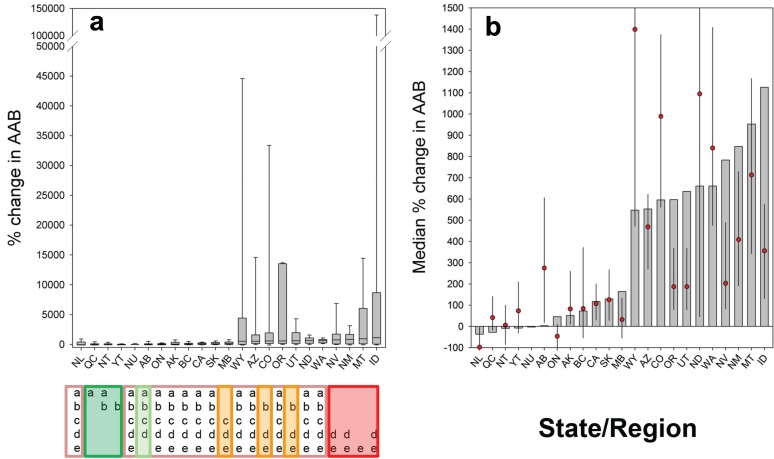
Changes in AAB across United States and Canada by state/province.(a) Boxplot of percent change in AAB (2010–2039 vs.1961-2004, SRES A1B scenario) binned by US state or Canadian province, based on significant models with p < 0.05. Sharing of any letter (below the graph) indicates lack of significant differences in medians of percent change in AAB based on Bonferroni-corrected a posteriori comparisons of a Kruskal-Wallis median test. Colored boxes indicate groups of states/regions with statistically similar medians ordered from low (green) through high median values (red). (b) States/regions ordered by increasing median change in AAB. Histograms are model projections based on the 1976–2006 baseline period; red dots are extrapolated increases in median AAB and bars are 95% confidence intervals estimated from Theil-Sen trends (1972–2015).